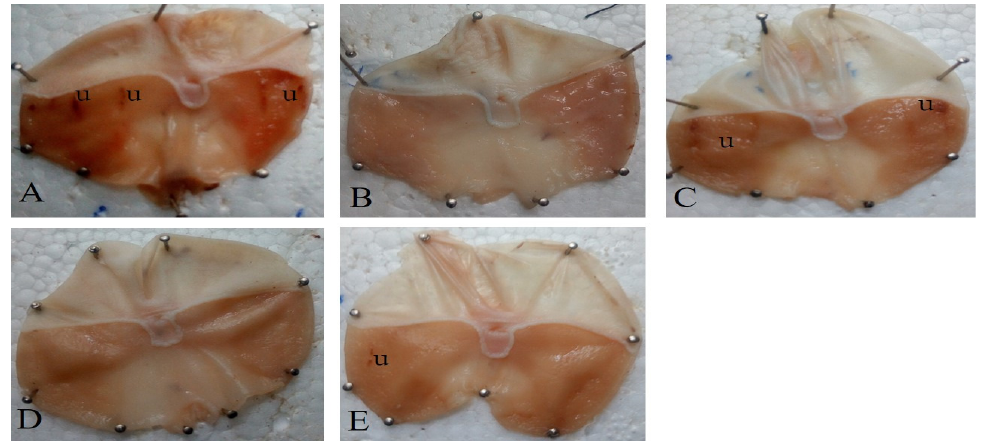
Figure 4. Gross morphology of stomach of ethanol-induced gastric ulcer in rats Legend: “U” = ulcer lesion, A = Distilled water 5 ml/kg, B = Misoprostol 50 µg/kg, C =MFCS 12.5 mg/kg, D = MFCS 25 mg/kg, E = MFCS 50